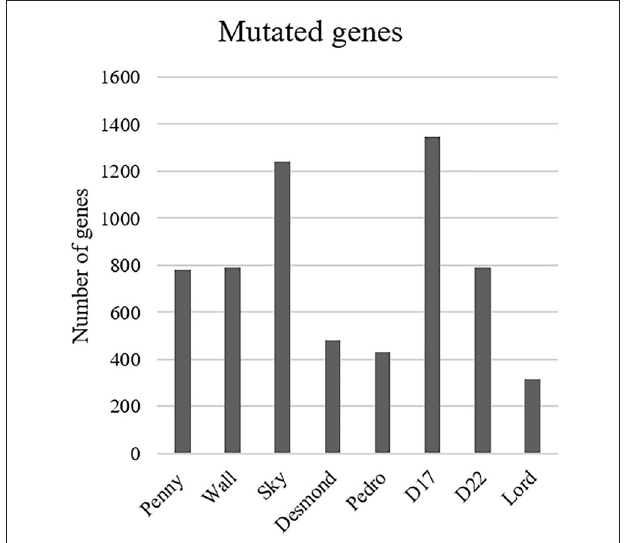
FIGURE 4 | Distribution of the mutated genes across the cell lines.